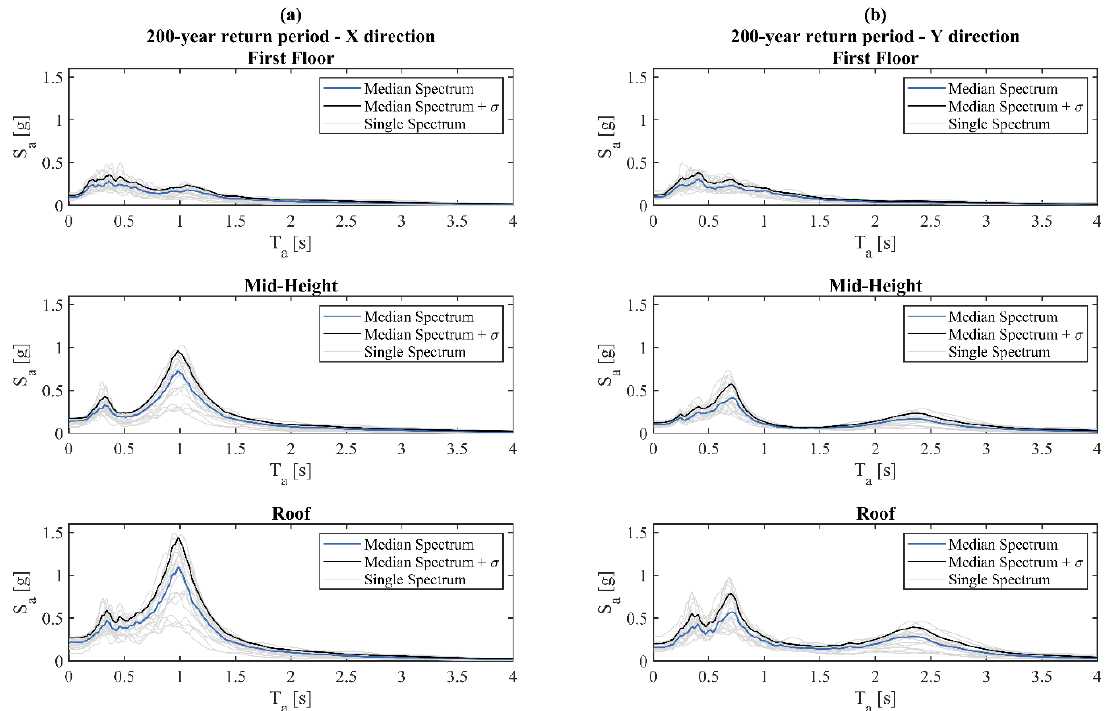
Figure 8. Acceleration floor spectra for RP = 200 years—First floor, mid-height and roof: ( a ) longitudinal, X direction; ( b ) transverse, Y direction.